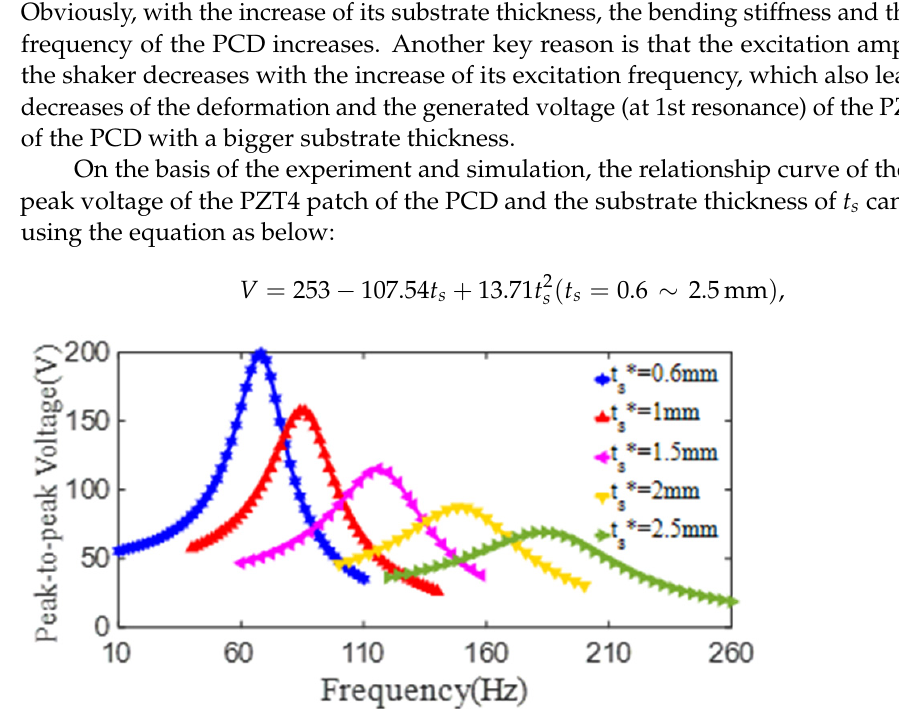
Figure 16. The relationship curves of the peak-to-peak voltage and the excitation frequency of PZT4 patch with different substrate thickness ( d p* = 80 mm, D p* = 135 mm, t p* = 1